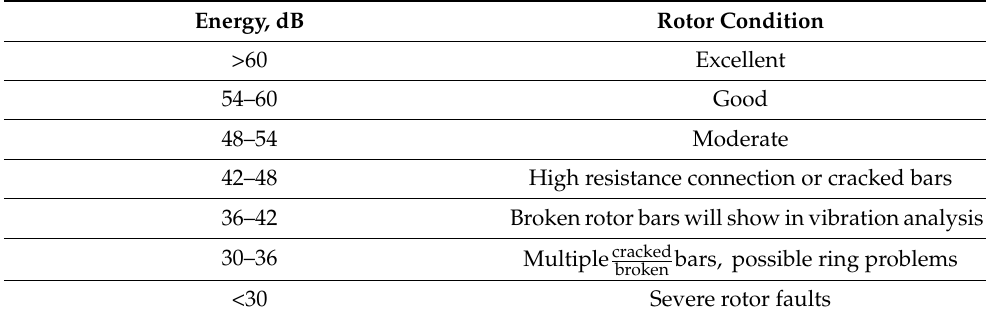
Table 1. Rotor condition sideband frequency failure signature.